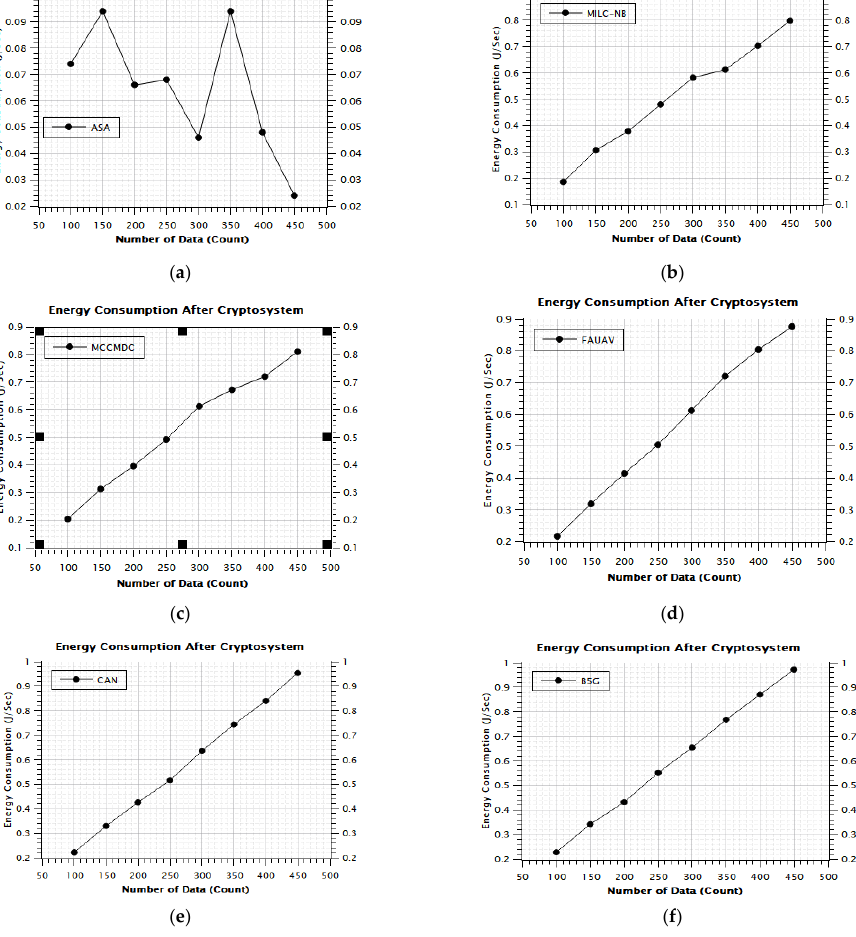
Figure 12. The energy consumption after cryptosystem assumption. ( a ) Energy Consumption After Cryptosystem (ASA), ( b ) Energy Consumption After Cryptosystem (MILC-NB), ( c ) Energy Consump- tion After Cryptosystem (MCCMDC), ( d ) Energy Consumption After Cryptosystem (FAUAV), ( e ) En- ergy Consumption After Cryptosystem (CAN), ( f ) Energy Consumption After Cryptosystem